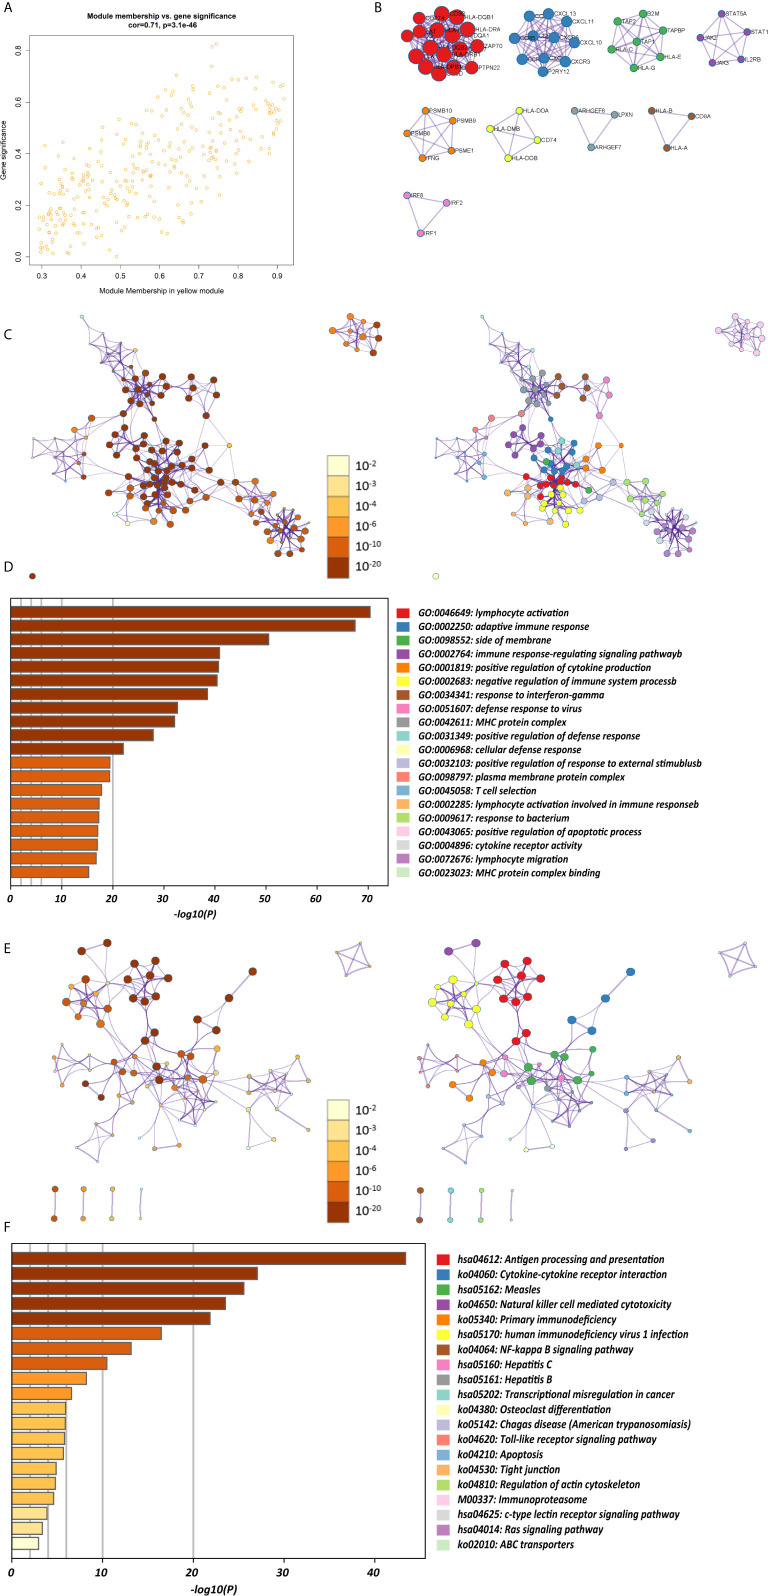
Functional and pathway enrichment analysis in the CD4+ MTRM. (A) Scatter plot of gene significance versus module membership in the CD4+ MTRM. (B) Subnetwork of gene in the CD4+ MTRM. (D, F) GO and KEGG enrichment analysis for genes in the CD4+ MTRM. (C, E) Interaction network of enriched biological processes in the CD4+ MTRM.